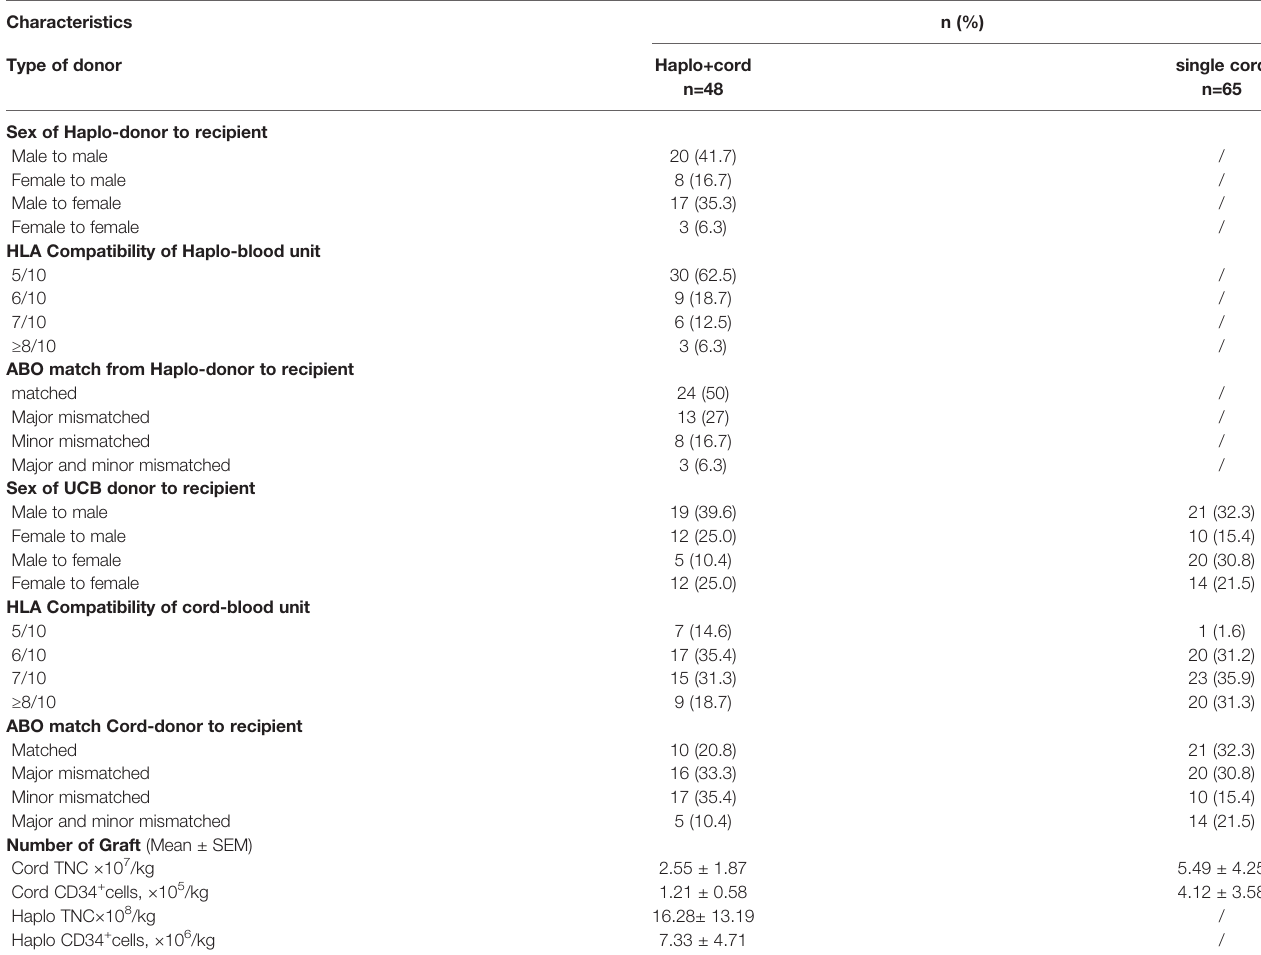
TABLE 2 | Graft characteristics of haplo+cord and single cord